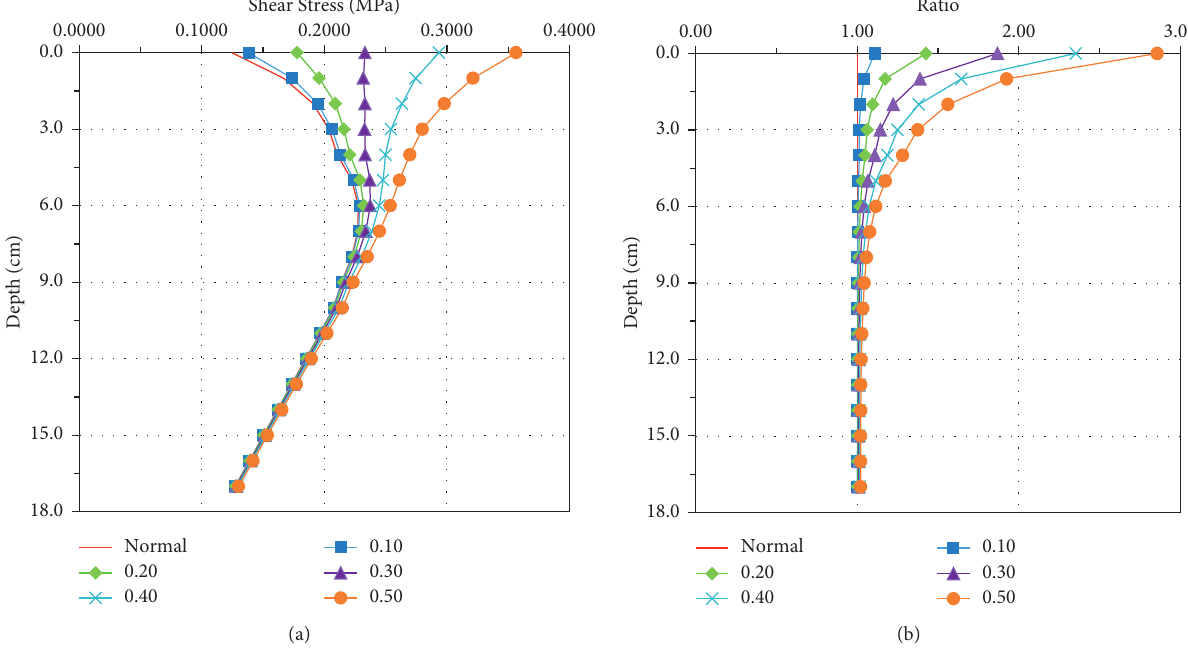
Figure 13: Effect of different horizontal forces on the distribution of shear stress alongwith the depth: (a) normal value and (b) standardized